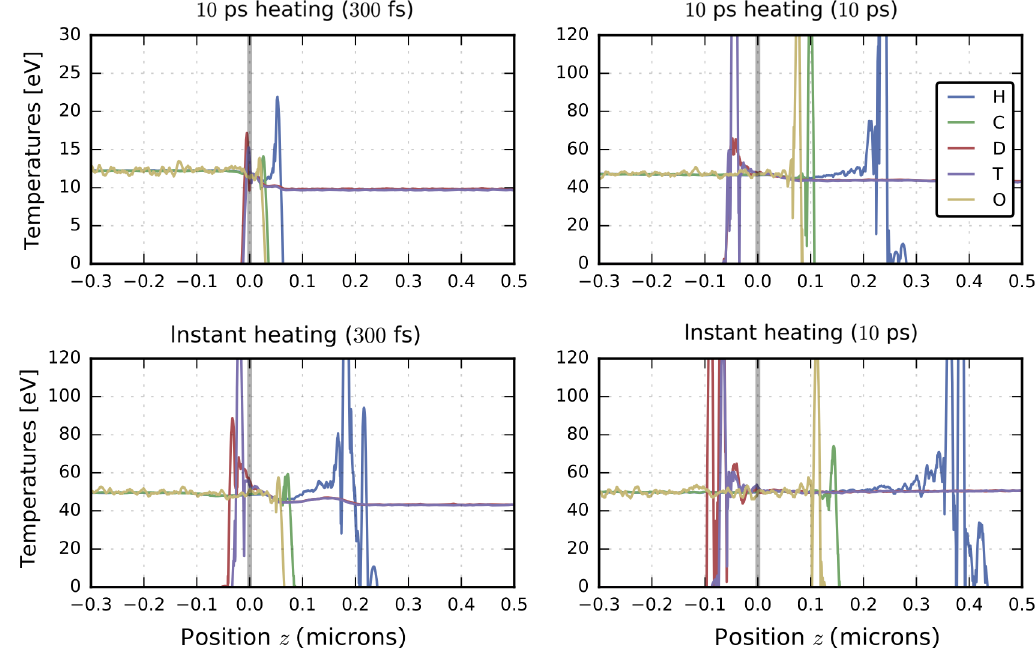
FIG. 10. Ion temperatures. Ion temperature profiles are shown for four cases, as in the previous figures. The hydrogen species attains temperatures that exceed the prescribed electron temperature by more than a factor of 2, which leads to slight heating of the DT fuel species away from the interface. This heating results from stopping the fast plastic species in the fuel region.